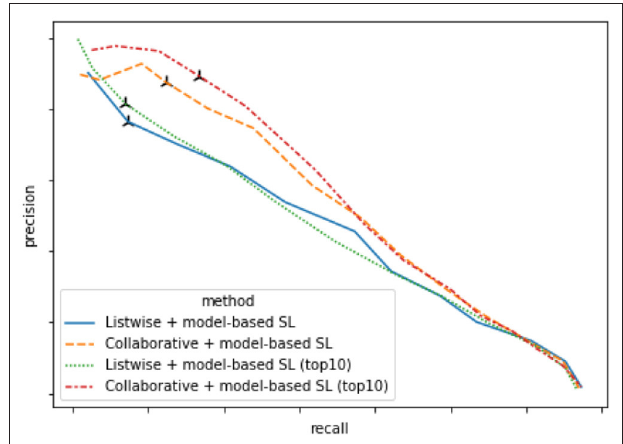
FIGURE 5 | Precision-recall curve of DNN-based RS’s performance with skill candidate length 40 vs. 10 computed on human annotation data.